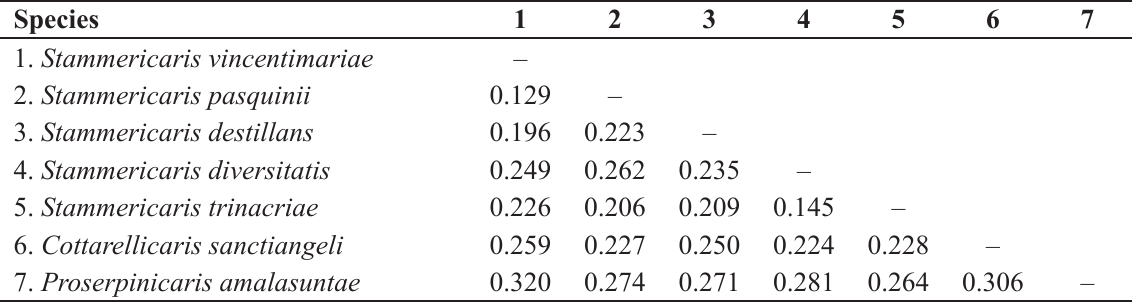
Table 3. Pairwise distances ( p -distance model) among COI sequences between the analysed species of